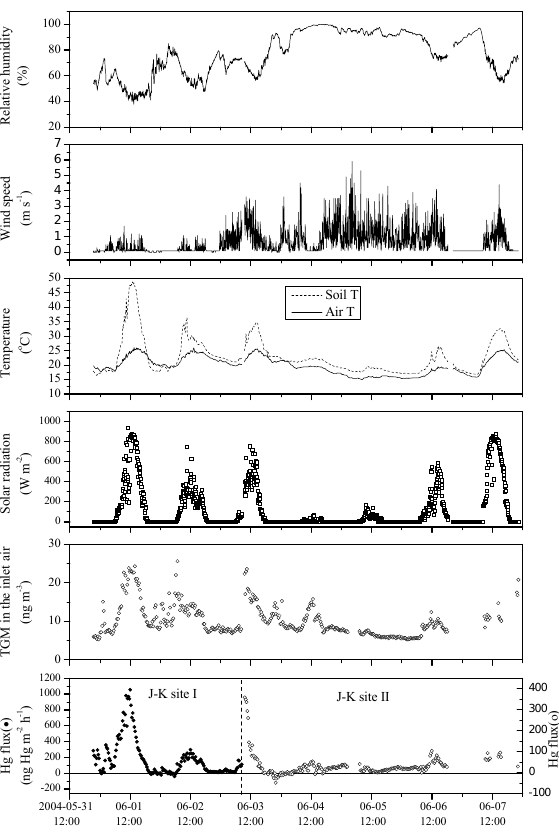
Fig. 6. Mercury surface-air fluxes at soil covering area of J-K landfill: the effect of weather conditions on the mercury emission rate.